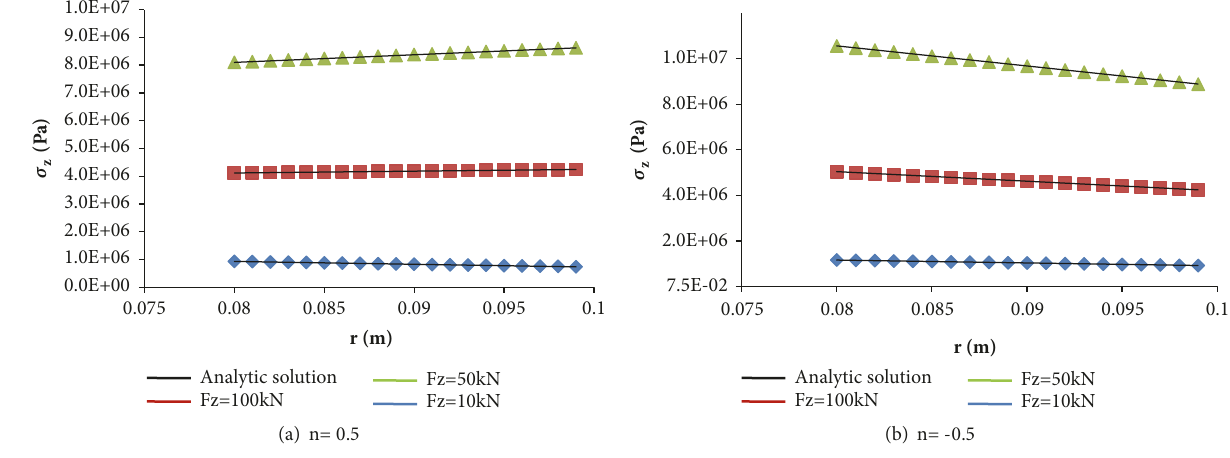
Figure 5: Vertical stress 𝜀 𝜃 as a function of the radial coordinate r : (a) for n= 0.5 , (b): n= -0.5 .